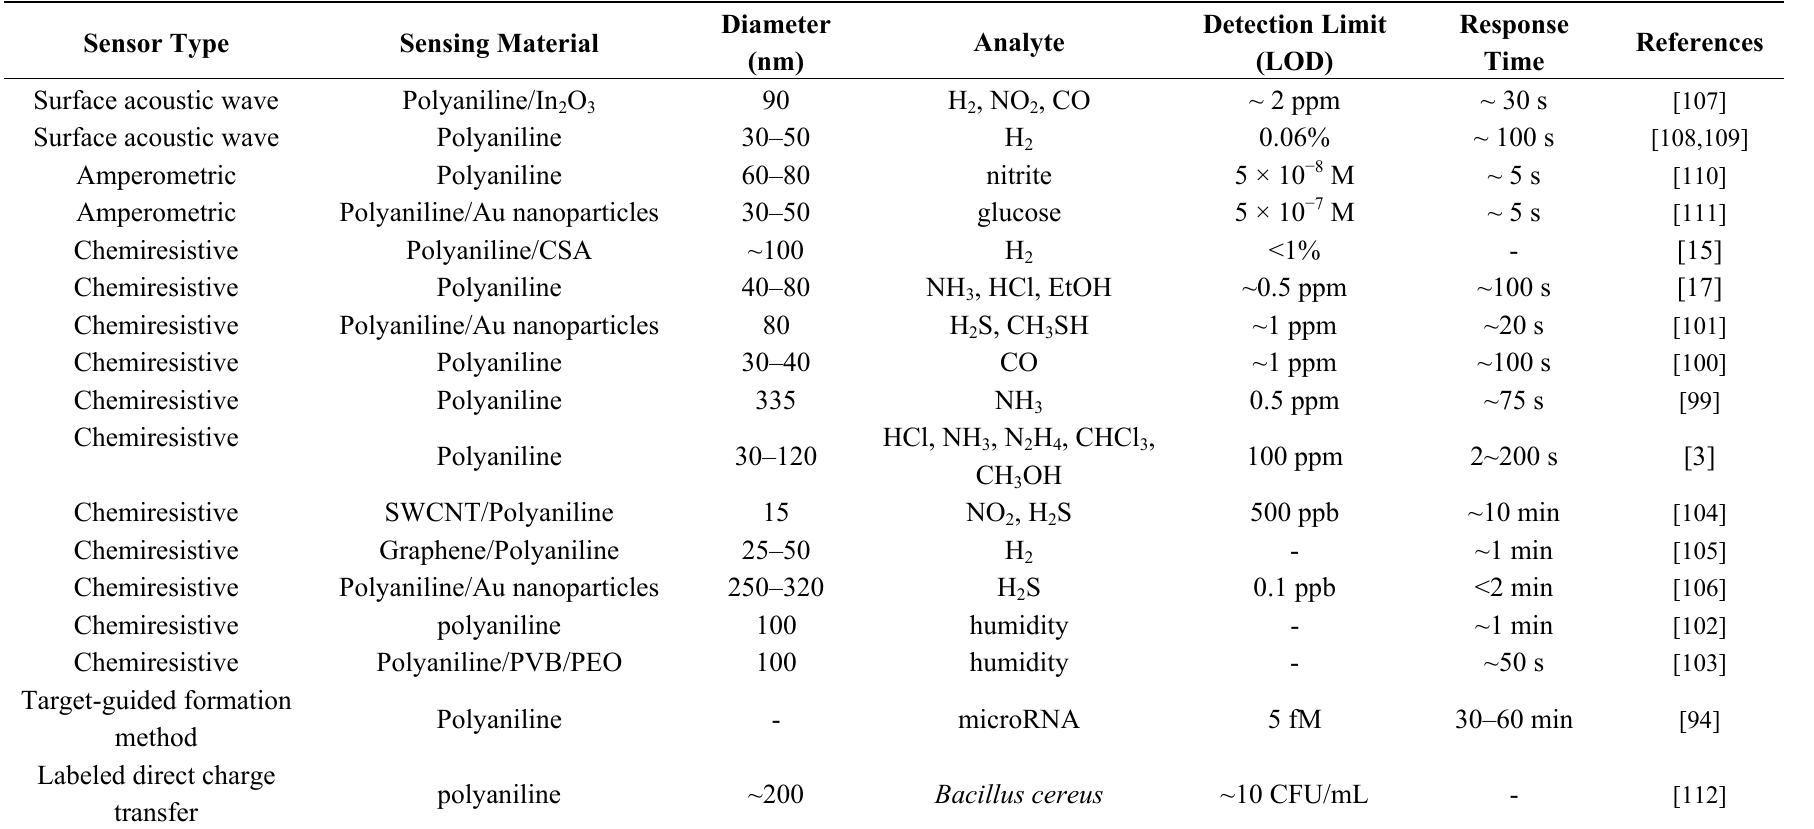
Table 1. Summary of chemical and biological sensors based on polyaniline nanowires and their